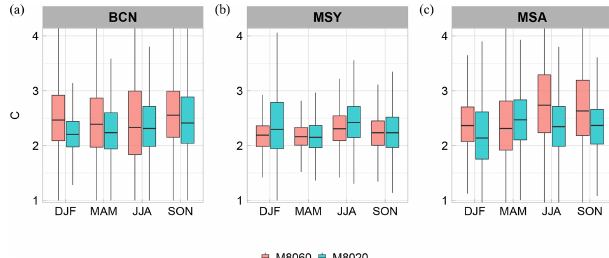
Figure 3. Seasonal evolution of the C factor at the (a) BCN, (b) MSY and (c) MSA measurement stations for both TFE-coated glass (M8020) and M8060 filter tapes. The box plot boxes show the range between the first and third quartile (IQR) with the median value for each season distribution represented by the inner line; the maximum whisker length is proportional to 1.5 times the third and first quartile difference, or inter-quartile range (1 . 5 ·